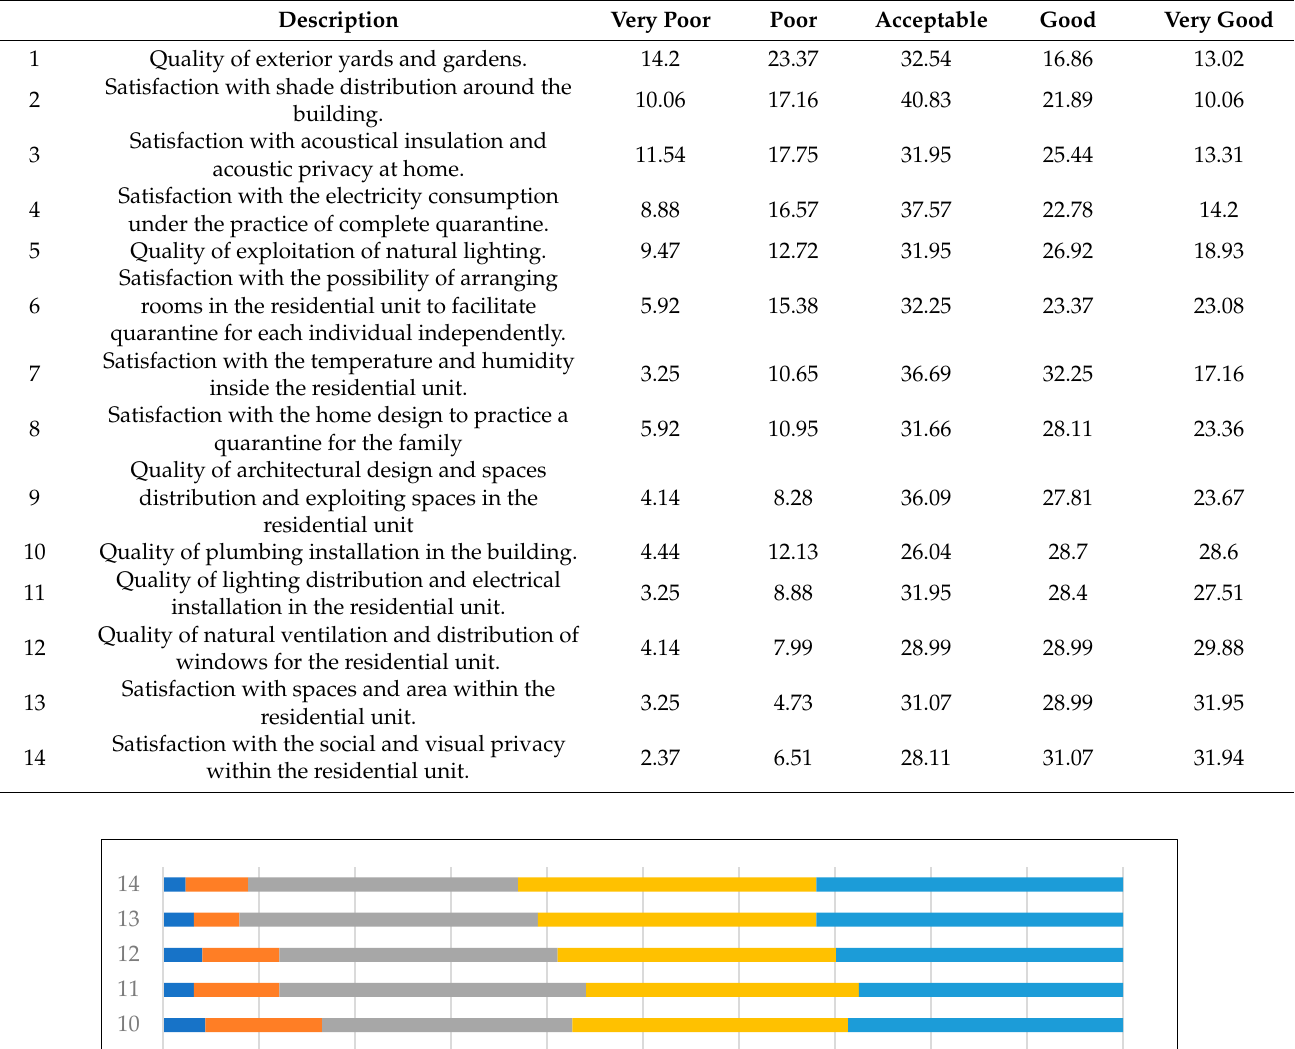
Table 3. The participants’ views of the quality of architectural design.